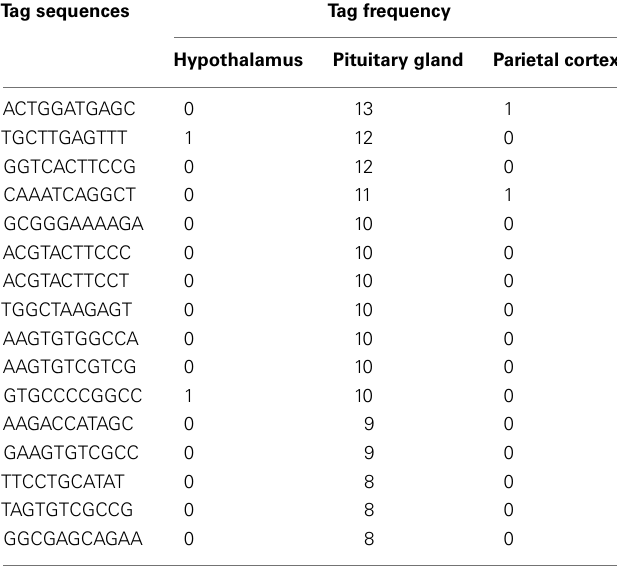
Table 8 | Potential novel transcripts in the hypothalamus and pituitary